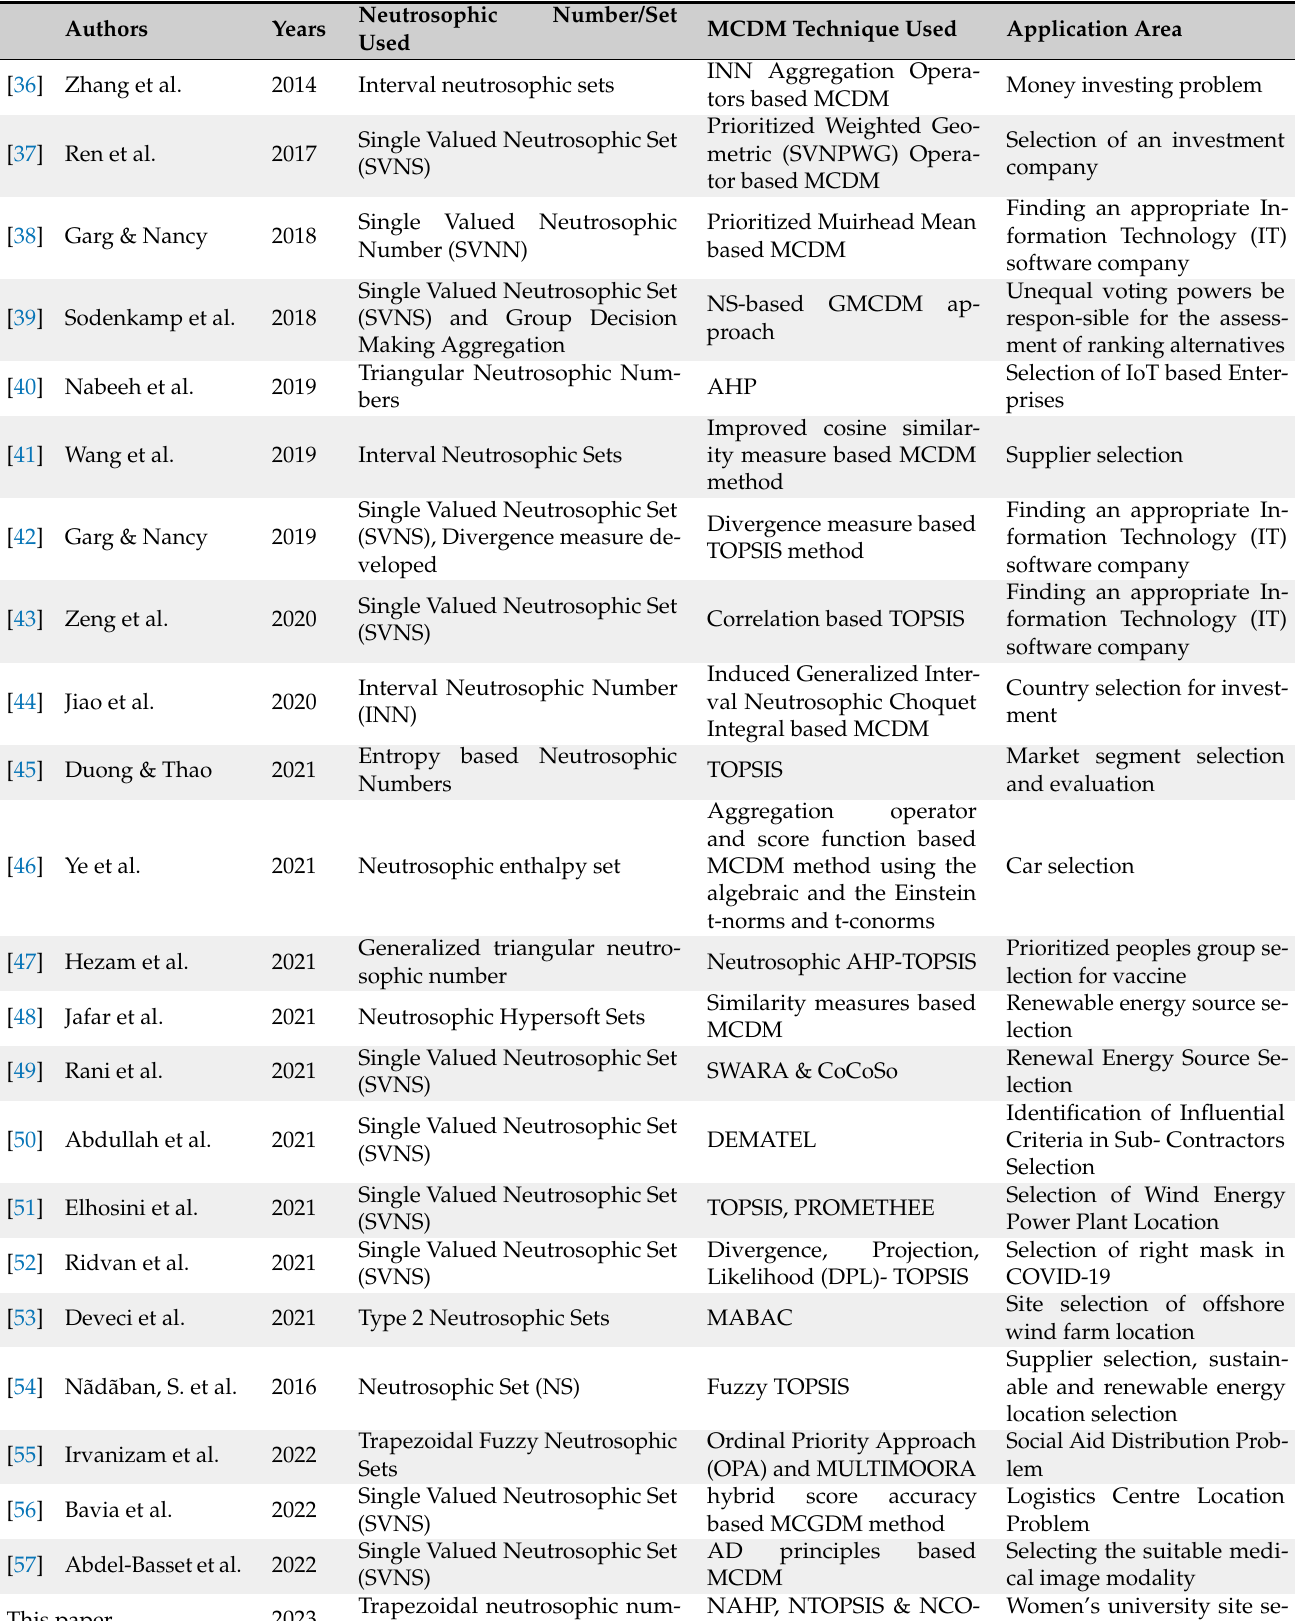
Table 2. Literature review based on theoretical developments by neutrosophic MCDM techniques along with application